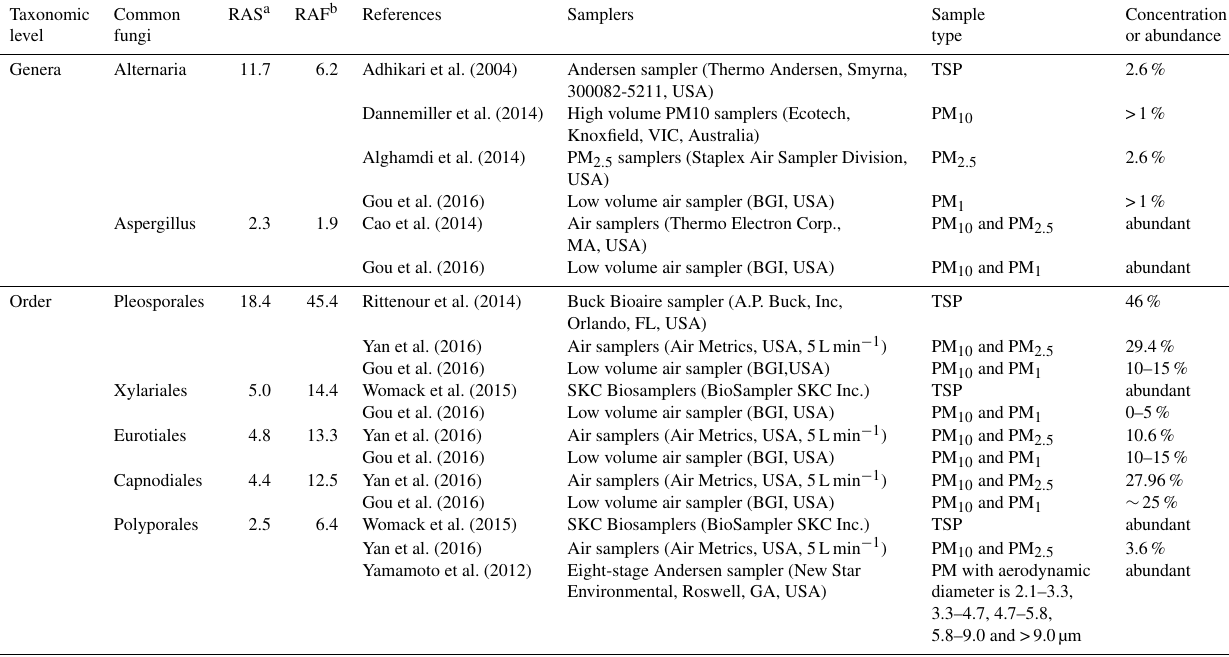
Table 2. The relative abundance of the top five orders and two genera in TSP, PM 10 , PM 2 . 5 , and PM 1 . Taxonomic